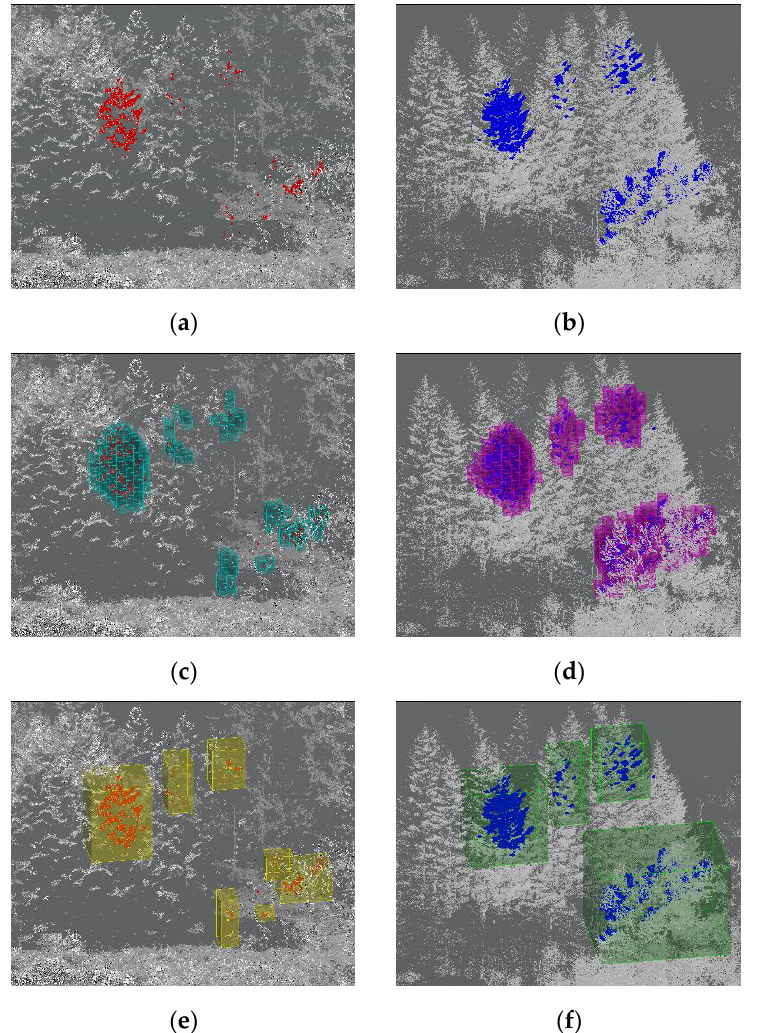
Figure 19. Exemplary results of obstacle detection for proposed methods and TLS reference data. Points recorded within the corridor ( a ) UAV, ( b ) TLS, calculated voxels ( c ) UAV, ( d ) TLS, clustered objects ( e ) UAV, ( f ) TLS.